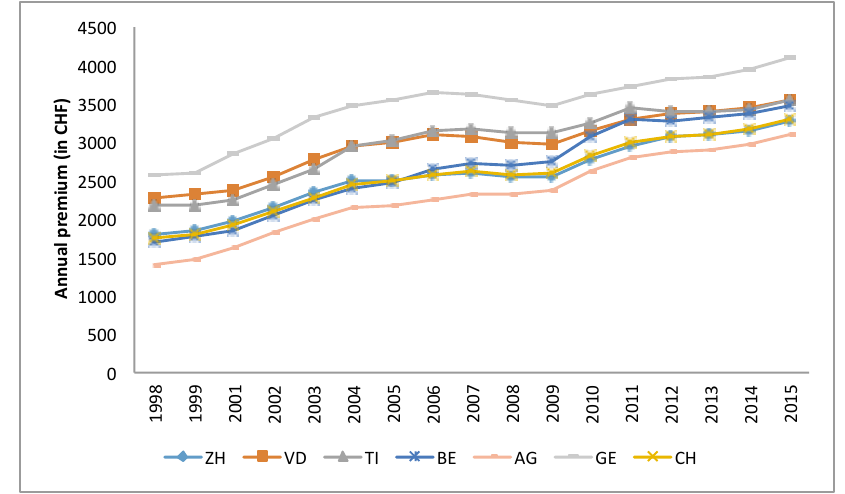
Figure 7. Average premium per canton,